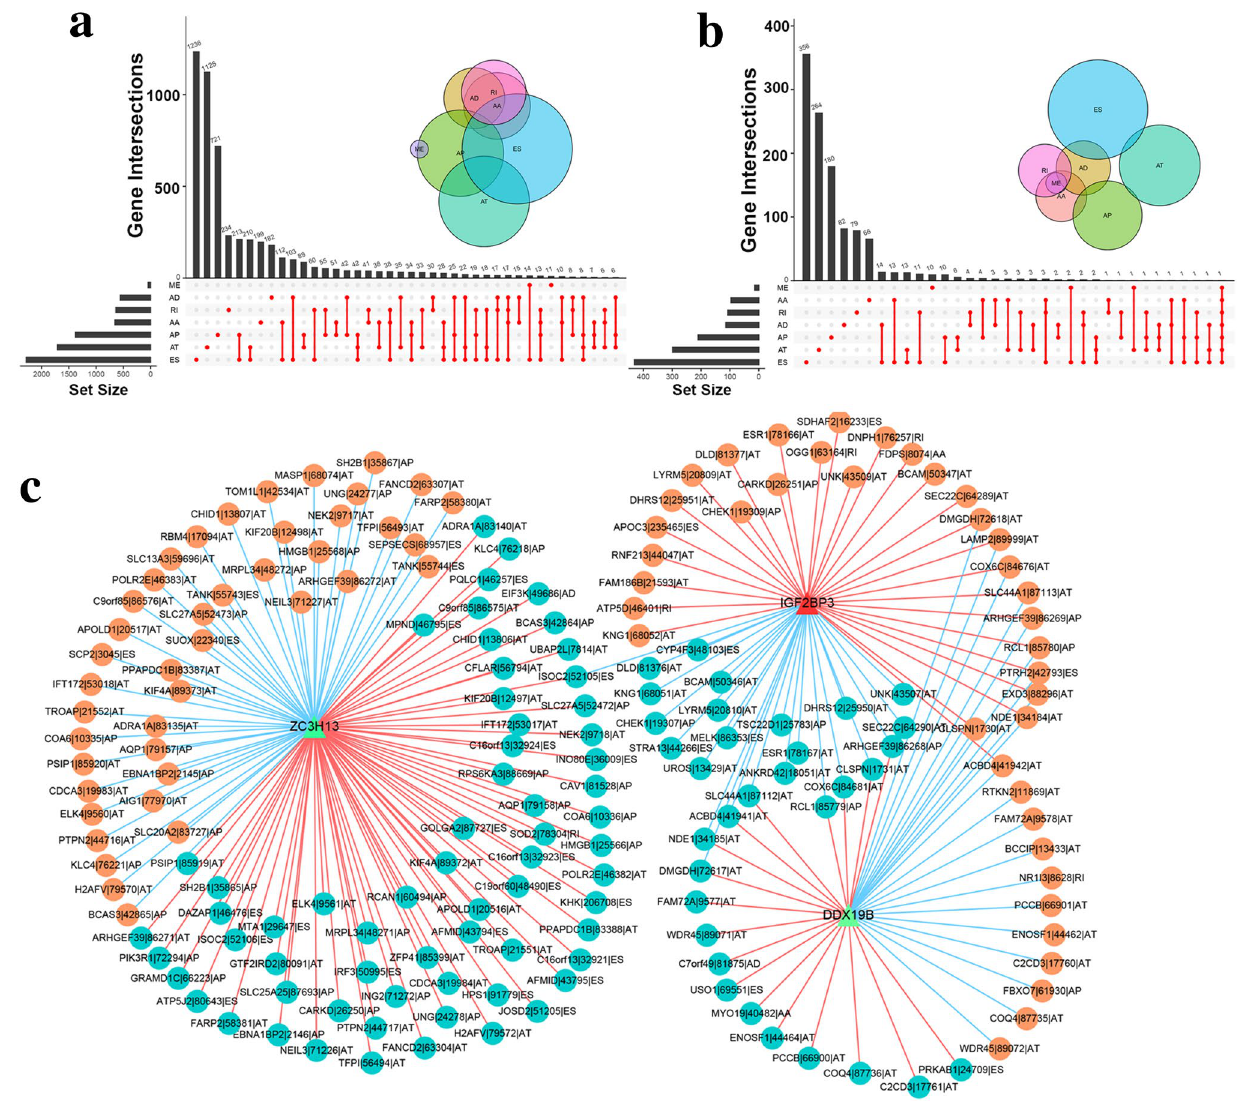
Figure 7. Construction of prognostic SFs-AS events regulatory network. ( a ) Upset plot and Venn diagram of parent gene interactions between the seven types of aberrant AS events in HCC. ( b ) Upset plot and Venn diagram of parent gene interactions between the seven types of prognostic AS events in HCC. ( c ) Regulatory network of SFs (ZC3H13, IGF2BP3, DDX19B) and prognostic AS events in HCC. Green triangles represent SFs that were protective factors for HCC; red triangle represents SF that was risk factor for HCC; turquoise squares represent AS events that were protective factors for HCC; orange squares represent AS events that were risk factor for HCC. The red lines represent positive correlations while the blue lines represent negative promotes initiation and progression of multiple cancers, such as bladder cancer and colon cancer. In bladder cancer, IGF2BP3 was reported to enhance cell proliferation and inhibit cell apoptosis through activation of JAK/ STAT pathway 34 . In colon cancer, IGF2BP3 binds to the mRNA of CCND1 and VEGFA via recognizing m6A modification of CCND1 and VEGFA, and enhances their mRNA stability, which facilitates cell proliferation and angiogenesis respectively 35 . A recent study has confirmed IGF2BP3 directly regulates alternative splicing of PKM and BTF3 and thus contributes to lung tumorigenesis 36 . ZC3H13 (zinc finger CCCH domain ‐ containing protein 13), a classical CCCH zinc finger protein, inhibits proliferation and invasion of colorectal cancer cells via blocking the Ras-ERK signaling pathway 37 . DDX19B (DEAD-box Helicase 19 B) participates in regulating mRNA export and mRNA translation 38 . To date, the role of DDX19B in cancers remains unclear. Collectively, the roles of DNAJC6, IGF2BP3, and ZC3H13 in regulating cancer progression as mentioned in above studies are consistent with our present study, indicating the results based on our study are reliable. However, there is limited research on the roles of DNAJC6, IGF2BP3, ZC3H13, and DDX19B in the regula- tion of AS events. Therefore, we explored the correlations between these SFs (DNAJC6, IGF2BP3, ZC3H13, and DDX19B) and prognostic AS events. Then we extracted protein-coding genes from AS events regulated by SFs mentioned above for further functional exploration. seven pathways (glyoxylate and dicarboxylate metabolism,